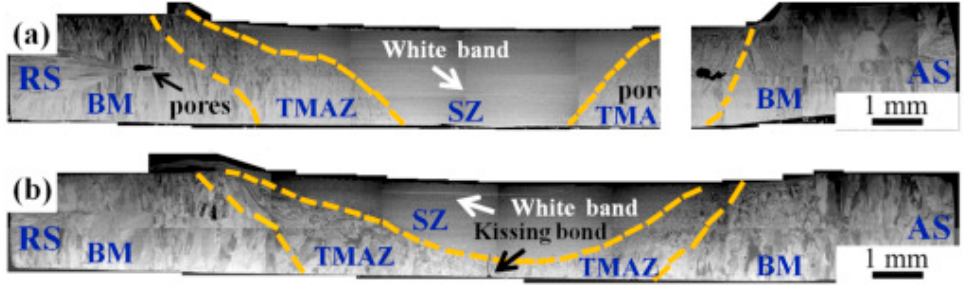
Figure 13. Macrostructure of the weld joint after welding at ( a ) 30 mm/min, ( b ) 50 mm/min Reproduced with permission from [100], Copyright Elsevier, 2018.